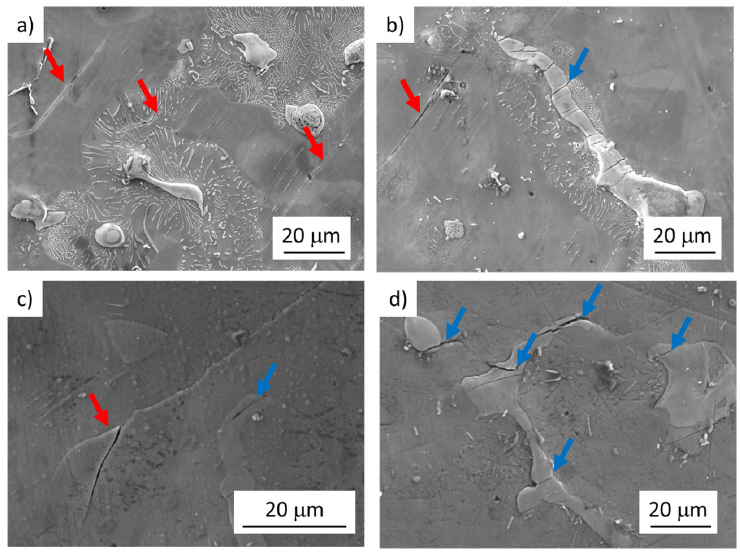
Figure 4. Fatigue crack initiation of AZ91 cast specimens tested at low frequencies. Red arrows indicate the cracks created on SMs. Blue arrows indicate the cracks in Mg 17 Al 12 particles; ( a ) well developed SMs in the solid solution areas, and cracks on SMs; σ a = 120 MPa, N f = 4,088 cycles, f = 10 Hz; ( b ) cracks on SMs and broken intermetallic particle; σ a = 120 MPa, N f = 4,088 cycles, f = 10 Hz; ( c ) tiny SMs in the solid solution areas, cracks on SMs and broken intermetallic particle; σ a = 85 MPa, N f = 20,170 cycles, f = 60 Hz; ( d ) broken intermetallic particles with cracks growing to the material; σ a = 85 MPa, N f = 20,170 cycles, f = 60 Hz.